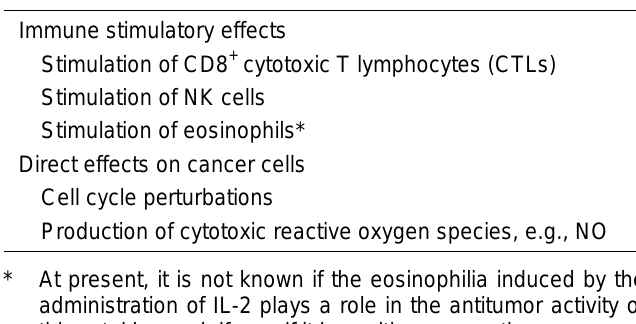
Biological Effects of IL-2 Potentially Implicated in